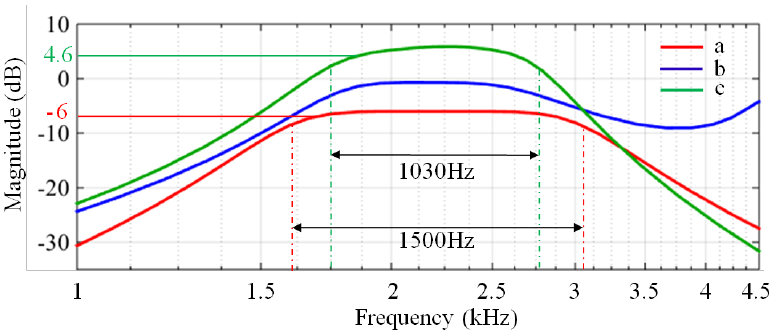
Figure 6. The amplitude-frequency characteristic curves of the filter. ( a ) The LC filter; ( b ) The LC filter connected with the pickup coil; ( c ) The LC filter connecting in parallel with a matching capacitor and the pickup coil.